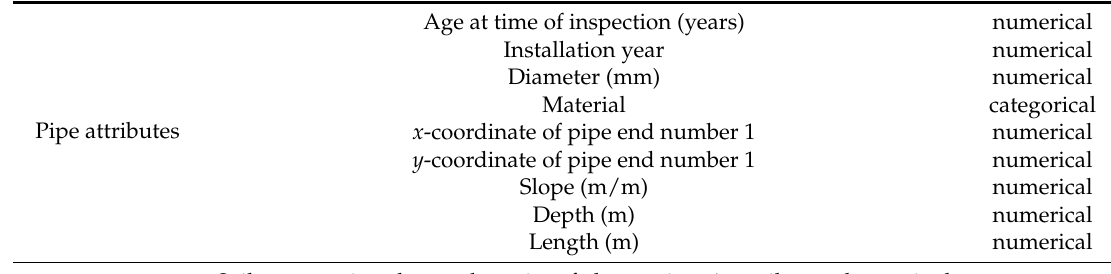
Table 1. Predictor variables